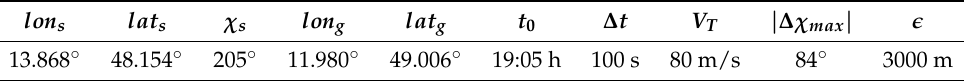
Table 12. Index s stands for start state and index g for the goal